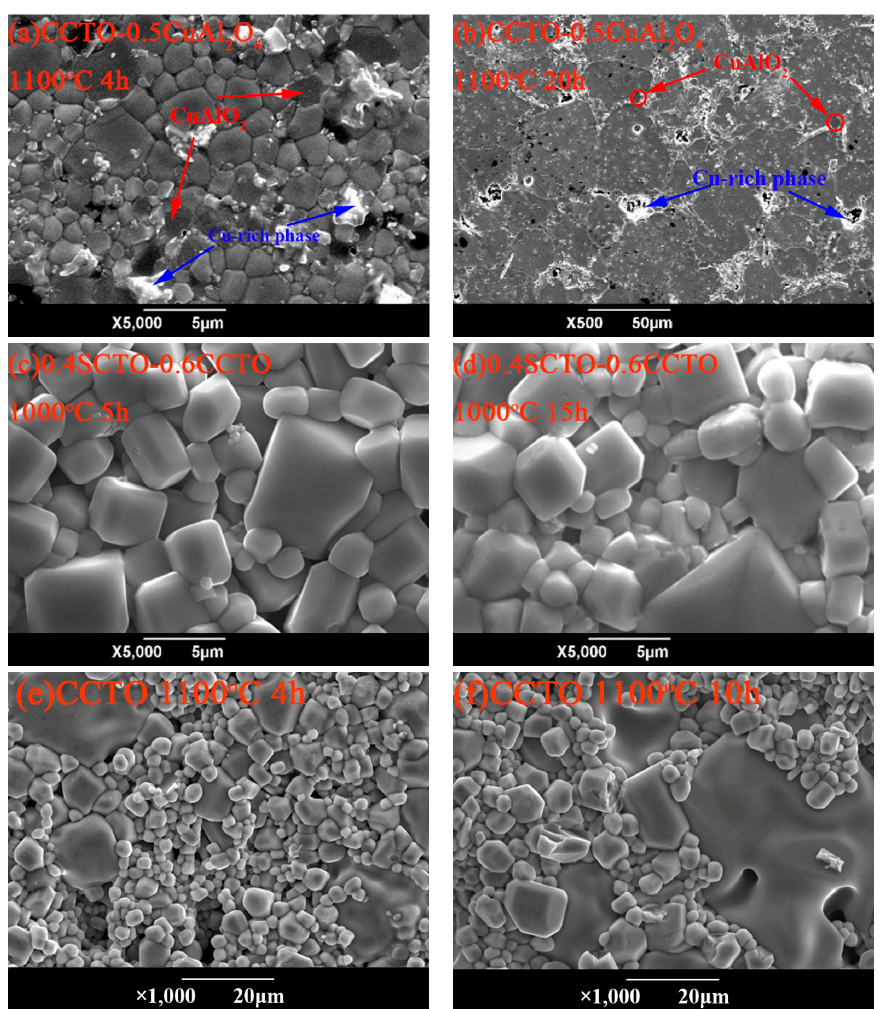
Figure 2. Microstructure of CaCu 3 Ti 4 O 12 -0.5CuAl 2 O 4 sintered for 4 h ( a ) and 20 h ( b ); 0.4SrCu 3 Ti 4 O 12 -0.6 CaCu 3 Ti 4 O 12 sintered for 5 h ( c ) and 15 h ( d ); and pure CCTO sintered for 4 h ( e )